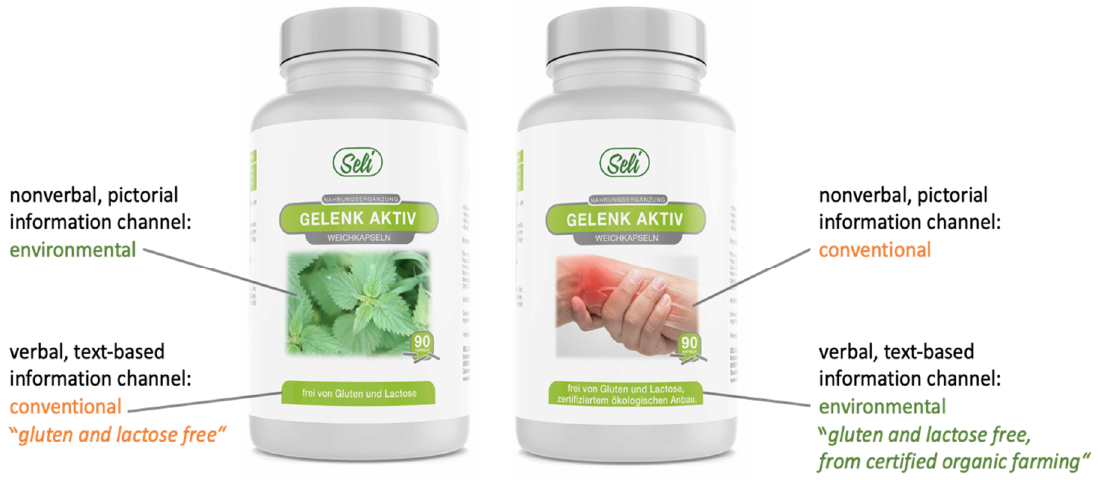
Figure 3. Design of the stimuli.